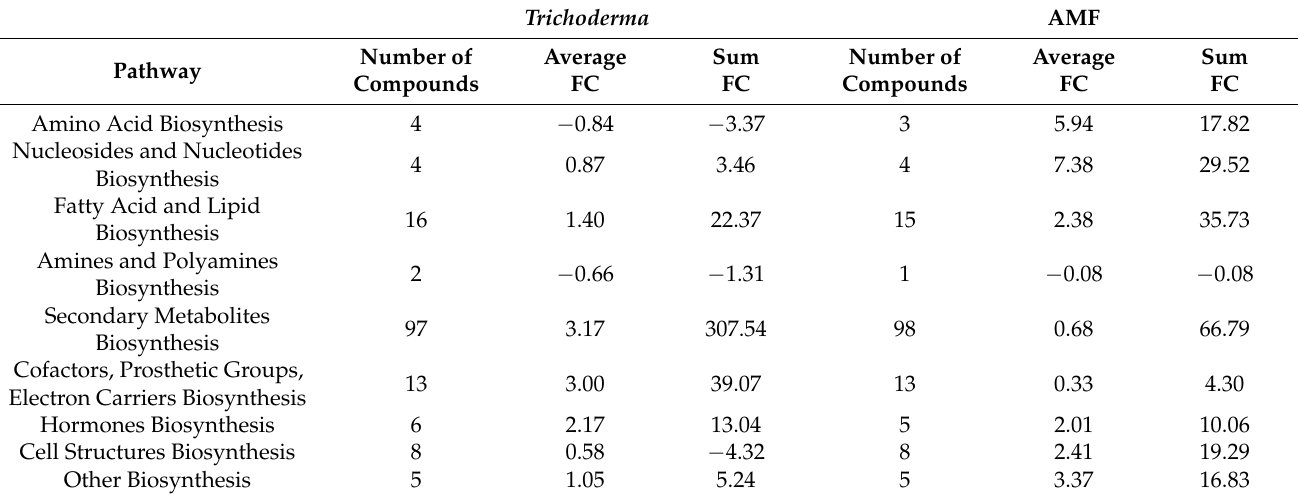
Table 2. Metabolic processes altered in tomato leaves as a result of the treatments, expressed as the total number of compounds, average of log fold-change (FC) and sum of log FC. The metabolomics dataset produced through UHPLC- ESI/QTOF-MS was subjected to ANOVA followed by FC analysis ( p < 0.05, FC ≥ 1.5), and differential metabolites were loaded into the PlantCyc Pathway Tool (https://www.plantcyc.org/, accessed on 18 April 2020).